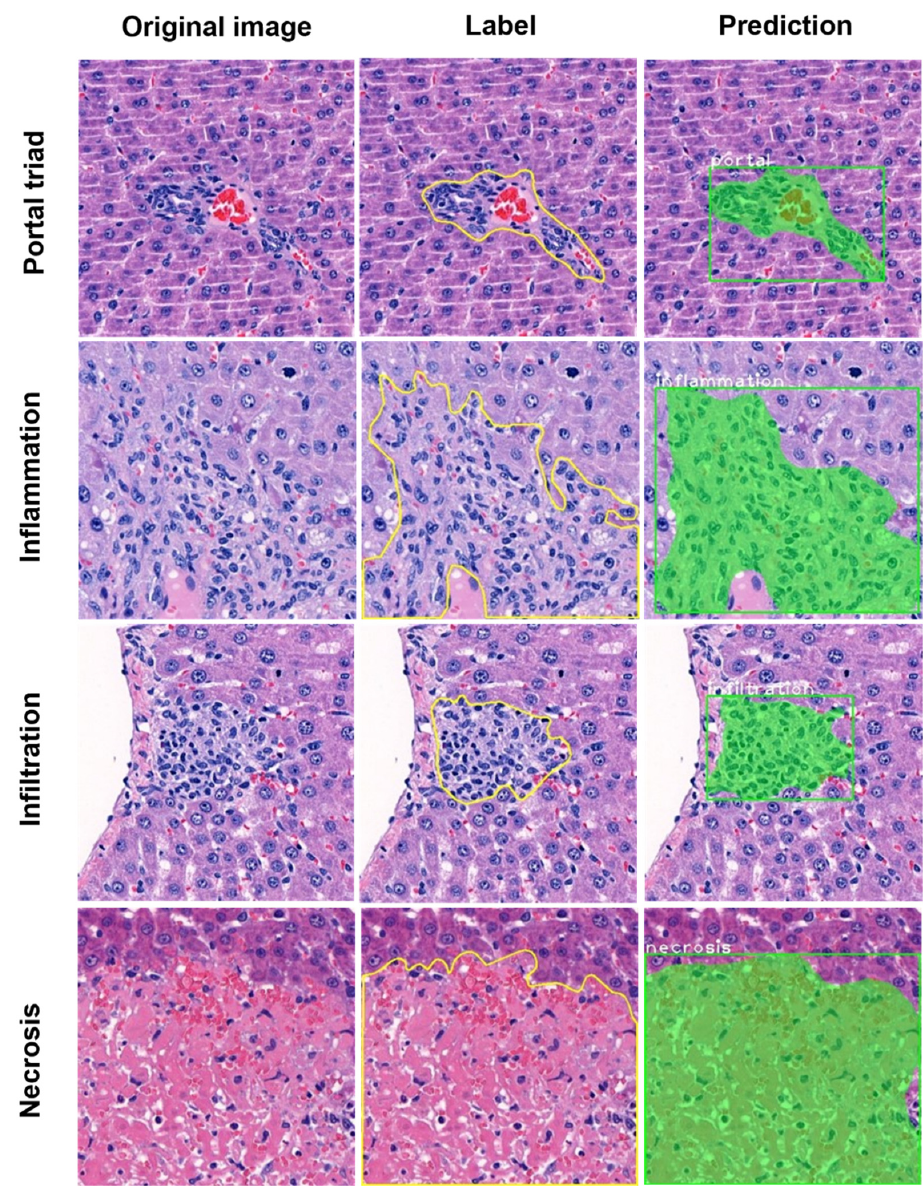
Figure 2. Representative segmentation for training and testing of hepatic lesions. The left panels show the original image tiles before labeling; the middle panels show labeled images for training of portal triad, necrosis, inflammation, and infiltration; the right panels show the predicted area for each lesion, as determined by Mask R-CNN.